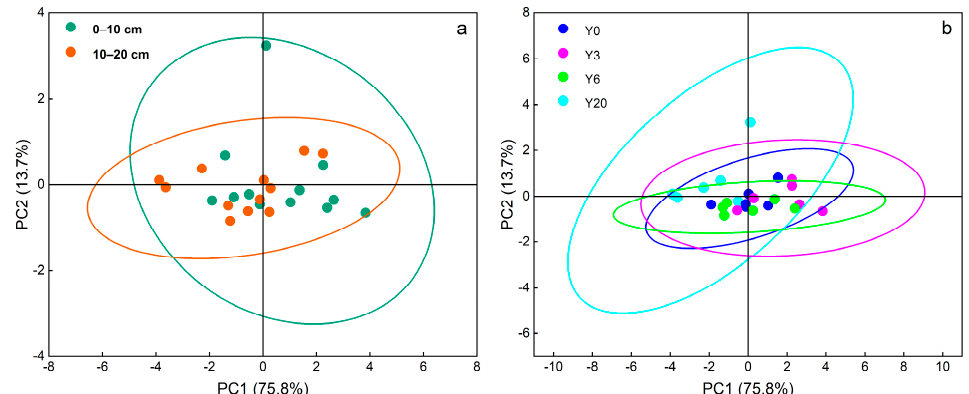
Figure 2. The principal components analysis (PCA) representing the variation in microbial community among different soil depths ( a ) and cropping years ( b ). Each datapoint represents the microbial community of the soil sample in each plot. Solid circles represent the 95% confidence intervals. See Figure 1 for abbreviations.